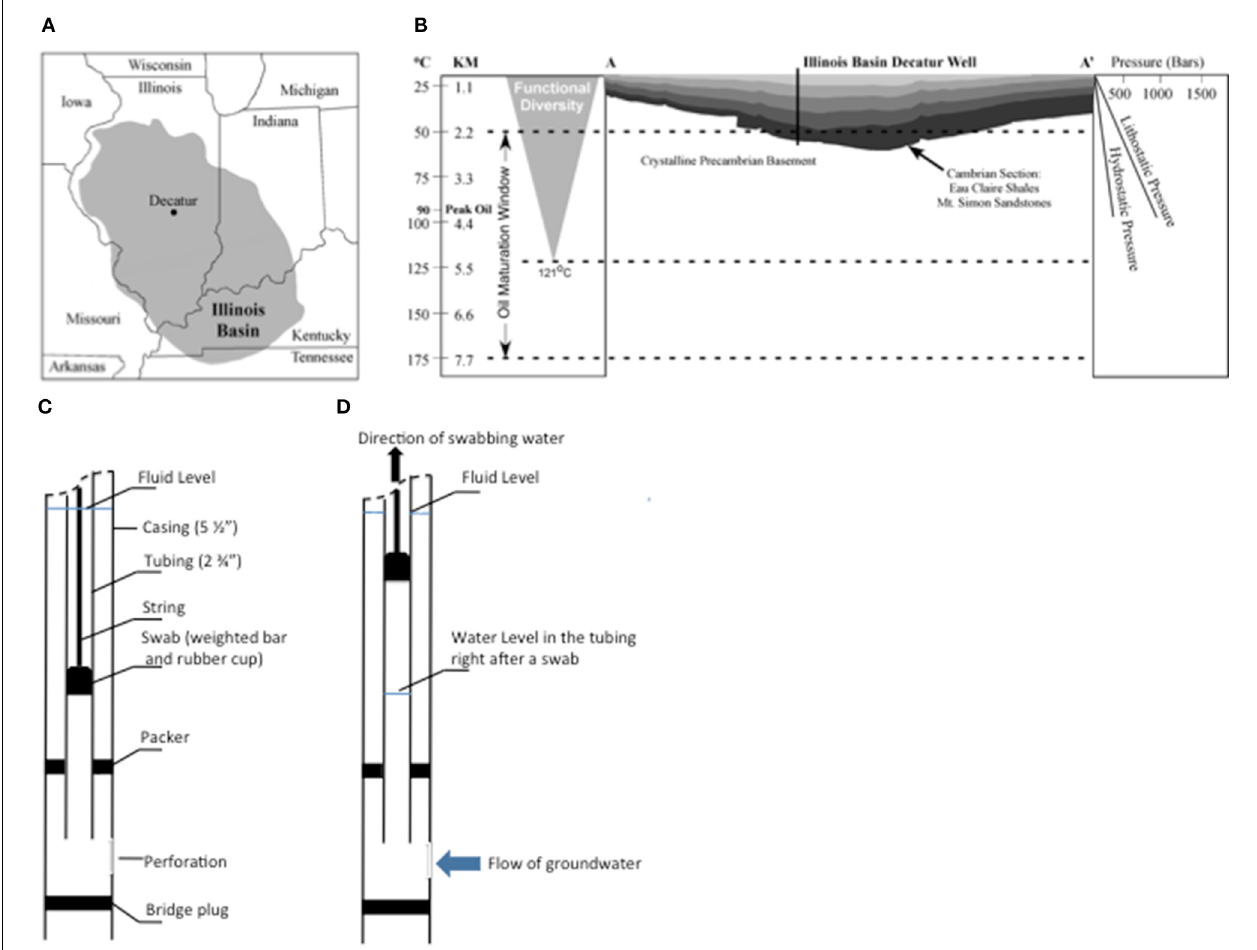
FIGURE 1 | Map of the Illinois Basin with the area highlighted in gray color (A), the geological line of section A–A’ (B) and diagrams of swabbing technique (C,D). In (B) , the changes of temperature and pressure along depth of the Illinois Basin are presented on both sides of the